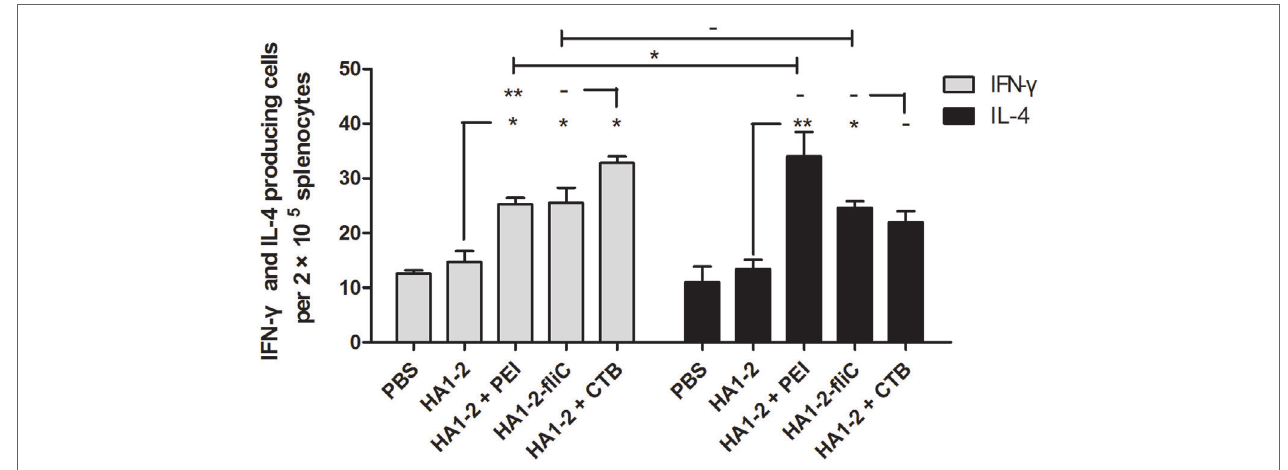
FigUre 6 | Quantitative analysis of interferon (iFn)- γ - and interleukin (il)-4-producing cells . On day 42, mice ( n = 6) were euthanized and single-cell suspensions prepared from the spleens were cultured for 48 h, then stimulated with purified protein HA1–2 (5 μ g/ml). IFN- γ and IL-4 secretion was detected in triplicate with the ELISPOT